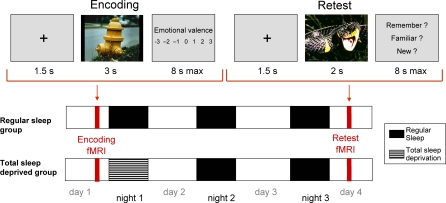
Experimental Protocol